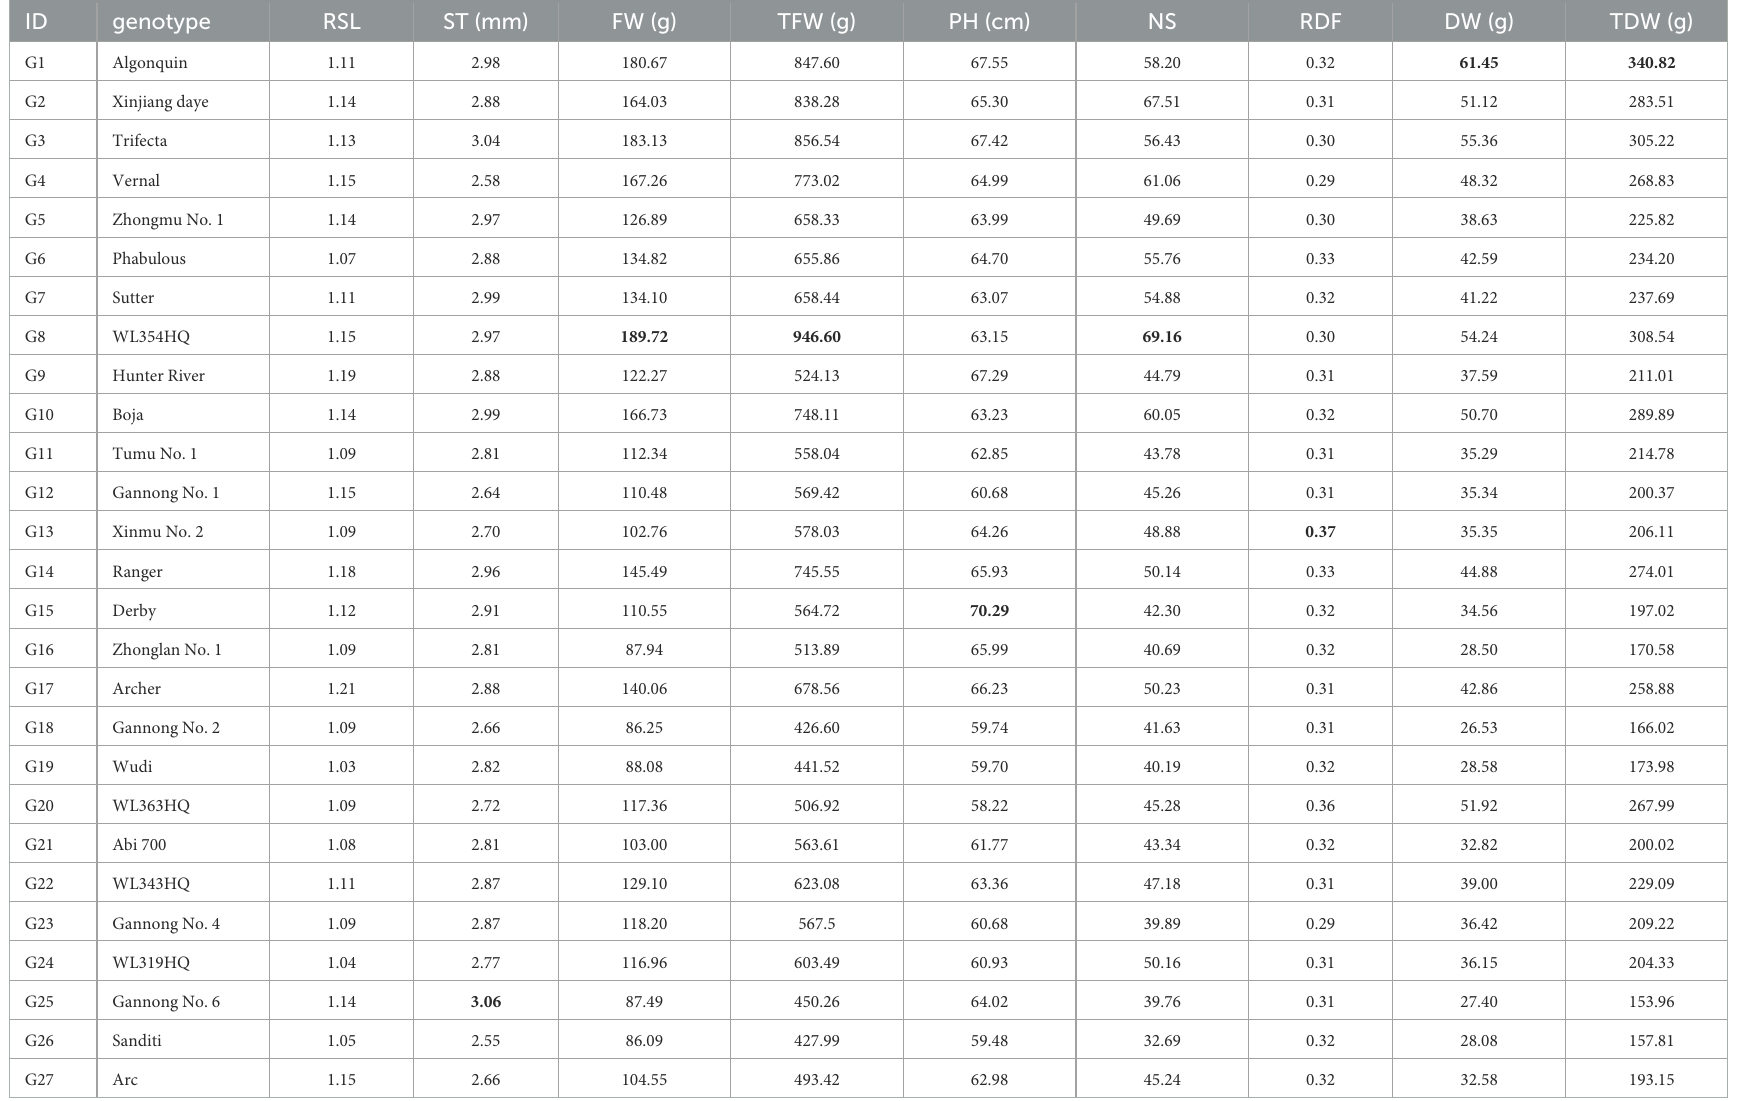
TABLE 5 Average, maximum, minimum, least significant differences ( l.s.d. 0.05 ), estimated genotypic ( σ 2 g ) and experimental error ( σ 2 ε ) variance components and associated standard errors ( ± SE), and mean repeatability ( R ) estimated from the 44 varieties of alfalfa evaluated in both 2019 and